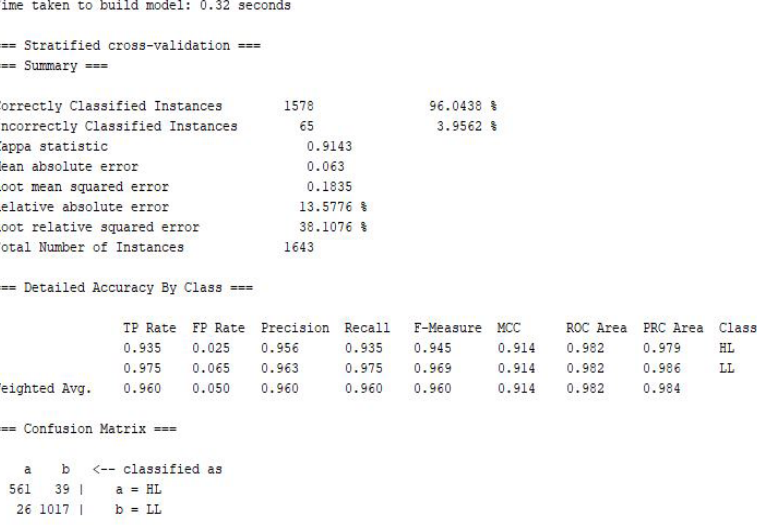
Figure 3: Logistic regression (LR) model for training dataset